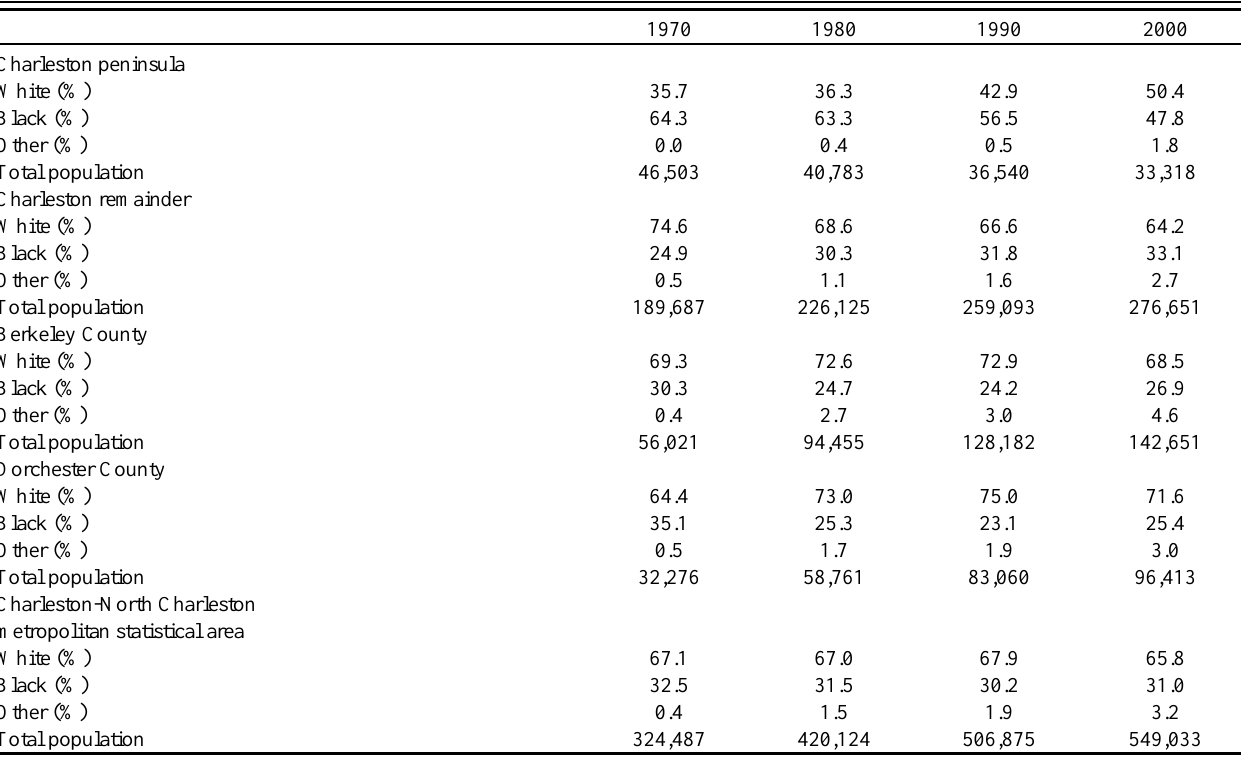
Table 2. Population and racial distribution in the Charleston area,